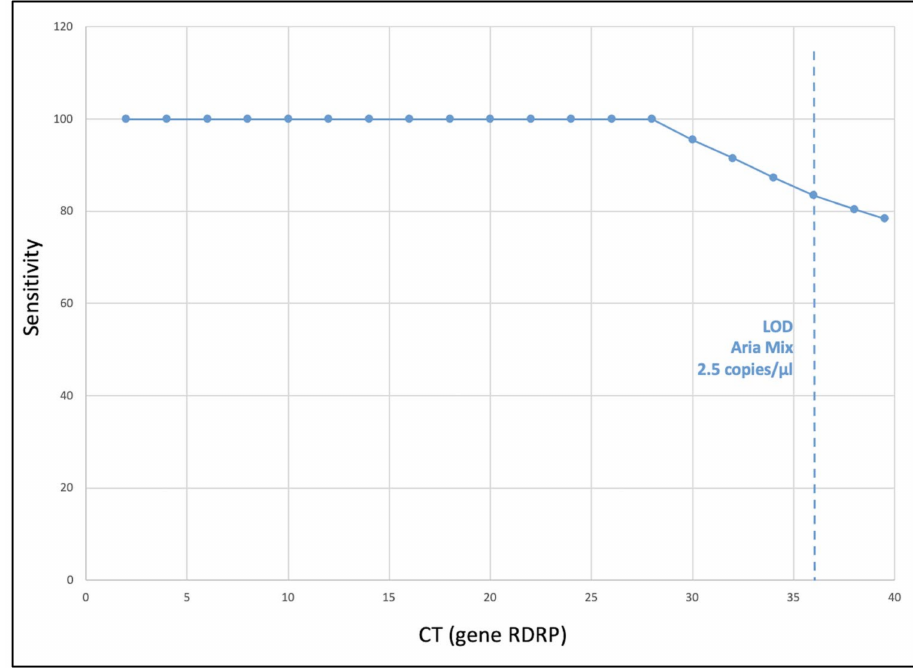
Figure 3. Sensitivity of the VitaPCR™. The figure represents the sensitivity of VitaPCR™ (false negative rate in relation to the overall positive) in relation to the CT obtained by the laboratory-based RT-PCR Aria Mix. Considering that the LoD of the Aria Mix was 2.5 copies/ µ L (36CT), the sensitivity of VitaPCR™ was calculated, including results up to 36